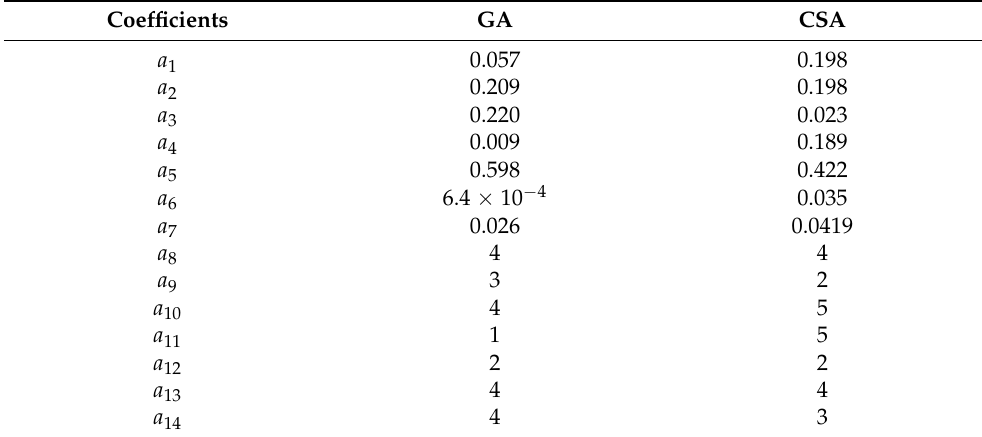
Table 4. Results of the coefficients and exponents obtained for both